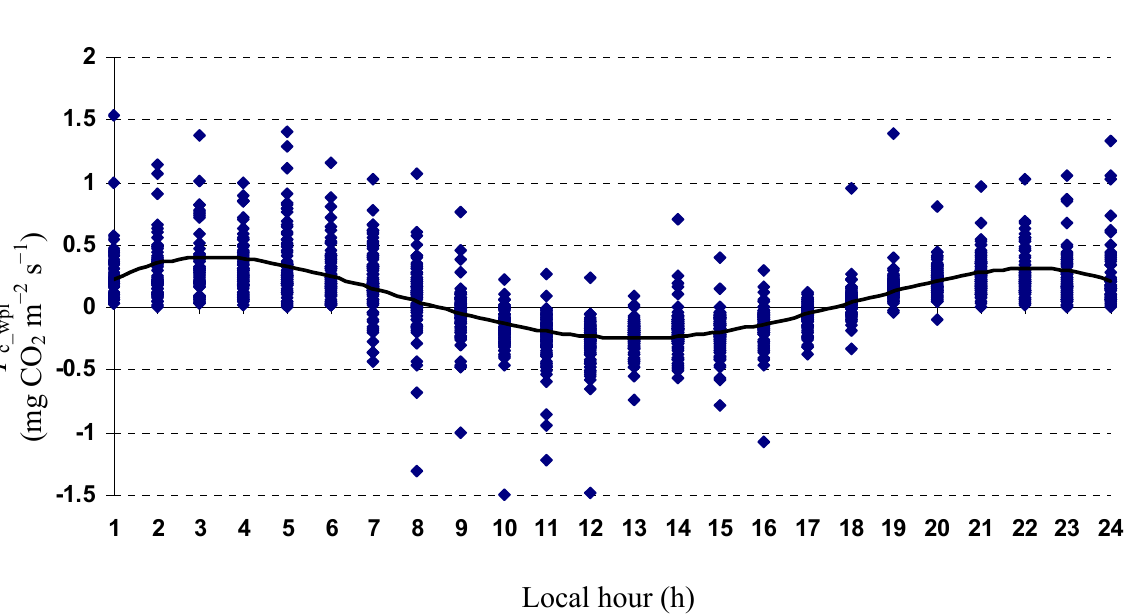
Figure 3. A quartic function fitted to the entire F the period of July 12 to October 17, 2010: F